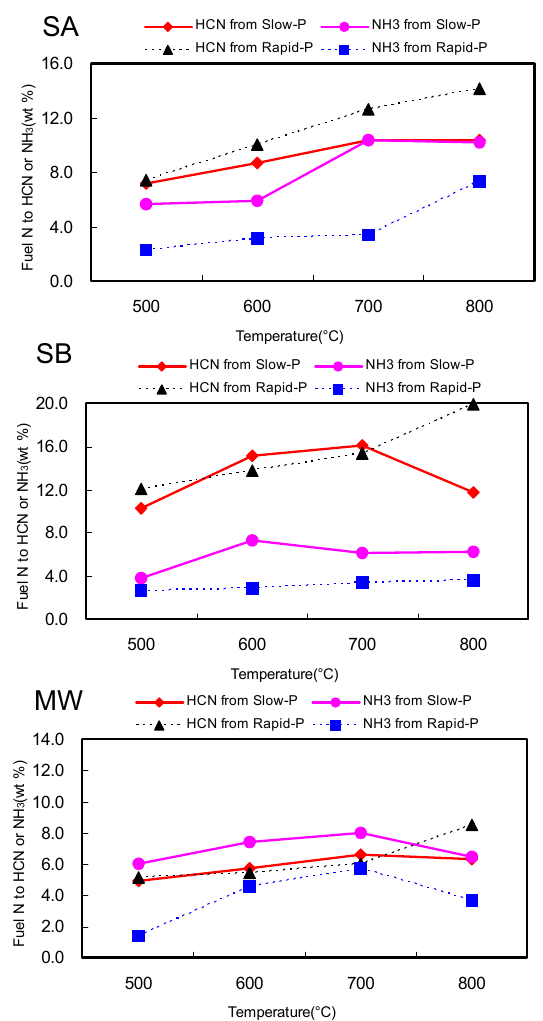
during a series of pyrolysis of 3